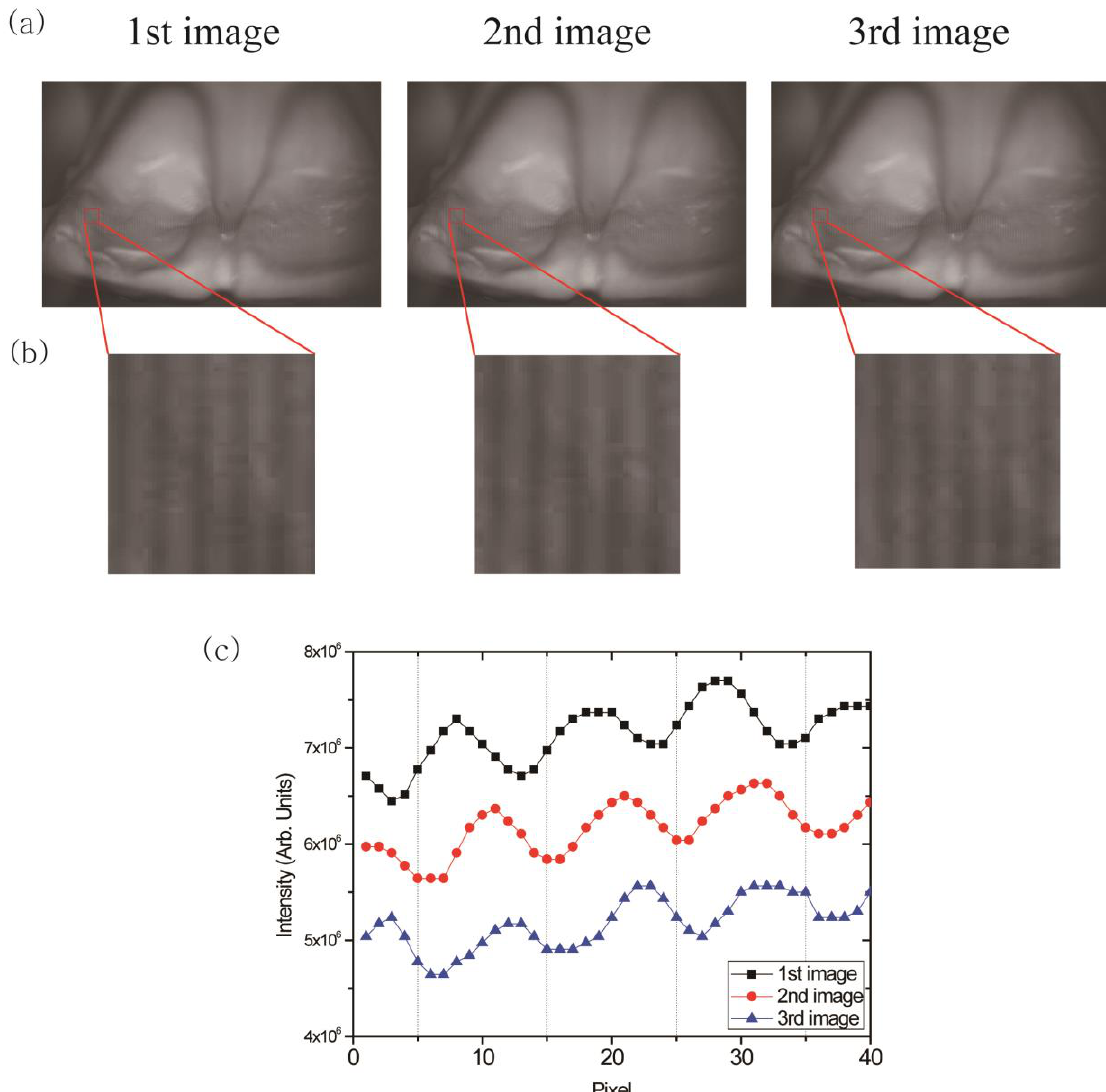
Figure 3. ( a ) Images (top row) of the dental gypsum cast and ( b ) magnified images (bottom row) of the in-focus area. Sinusoidal fringe patterns were visualized only within the in-focus areas. ( c ) The intensity profiles of the magnified images (Figure 3b) along the horizontal axis of the images. The intensity profiles were vertically translated for better discrimination. The sinusoidal fringe patterns were shifted by T/3 (T: periodicity of the patterns) between each image.